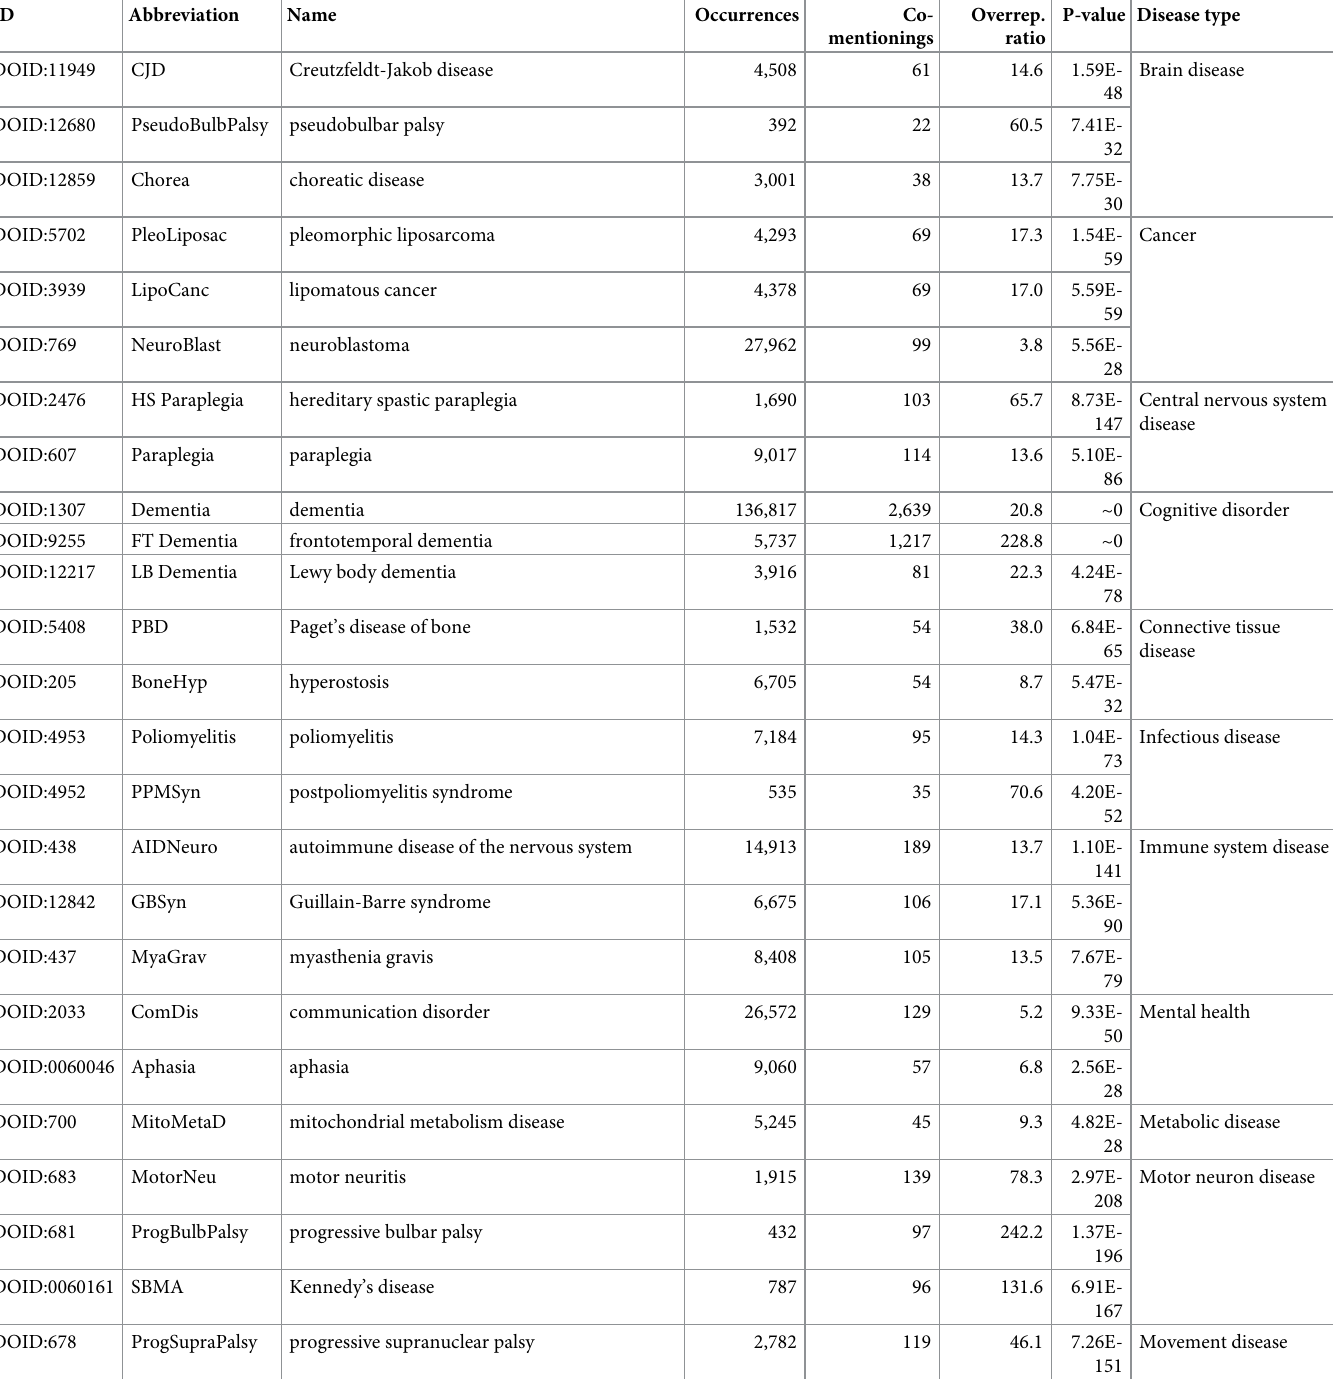
Table 3. Top 50 diseases most commonly co-mentioned with ALS in PubMed abstracts. List of the 50 diseases most commonly co-mentioned with ALS in scientific lit- erature. Diseases have manually been categorized into ‘Disease types’ guided by the tree structure in Disease Ontology [32, 33]. ID: Disease Ontology ID. Abbreviation: Short name for disease used in Figs 5–9. Name: Disease name in Disease Ontology. Occurences: Number PubMed abstracts mentioning disease. Co-mentionings: Number of PubMed abstracts where both disease and ALS are mentioned. Overrep. ratio: Overrepresentation ratio of co-mentionings. P-value: Significance of hypergeometric test of the overlap between disease and ALS. Disease type: Manual classification of